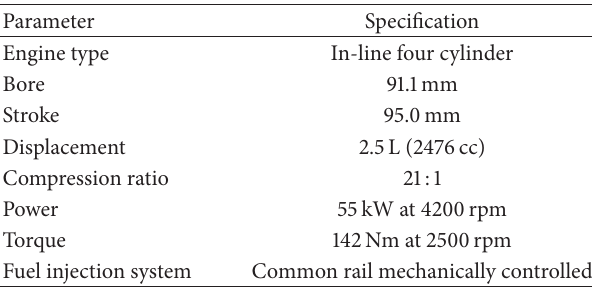
Table 1: Specification of the